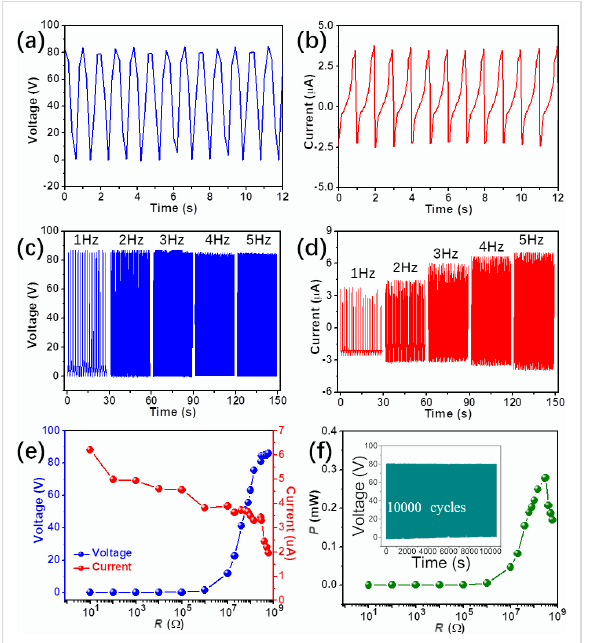
Figure 3: Electrical measurement results of the u-TENG. Open-circuit voltage (a) and short-circuit current (b) of the prepared u-TENG at an impact frequency of 1 Hz. Open-circuit voltage (c) and short-circuit cur- rent (d) of the prepared u-TENG under different frequencies ranging from 1 to 5 Hz. (e) Dependence of the output voltage and current on the external loading resistance. (f) Plot of the power density as a func- tion of the loading resistance; inset: long-term stability.